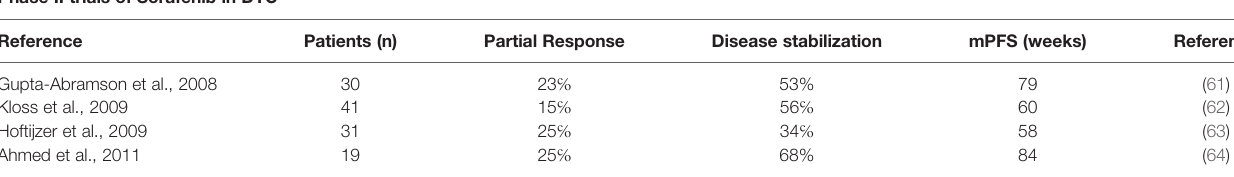
TABLE 3 | Phase II trial tested sorafenib in DTC.